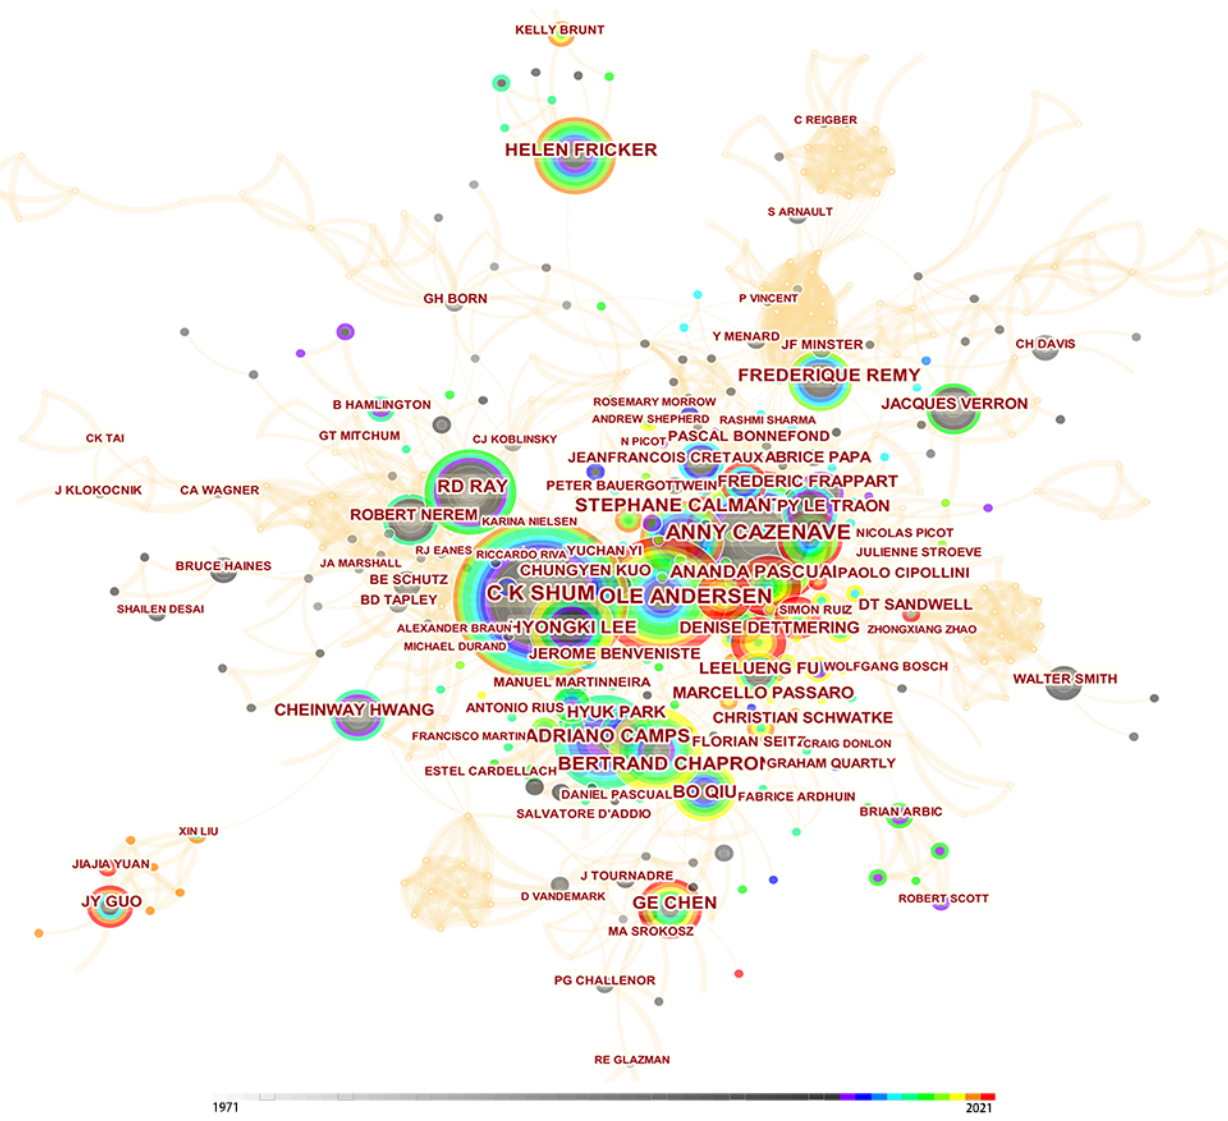
Figure 8. Collaboration network between key authors in satellite altimetry research. The node size and link line width represent the volume of publication and strength of cooperation for each authors, respectively. The node color indicates the publication